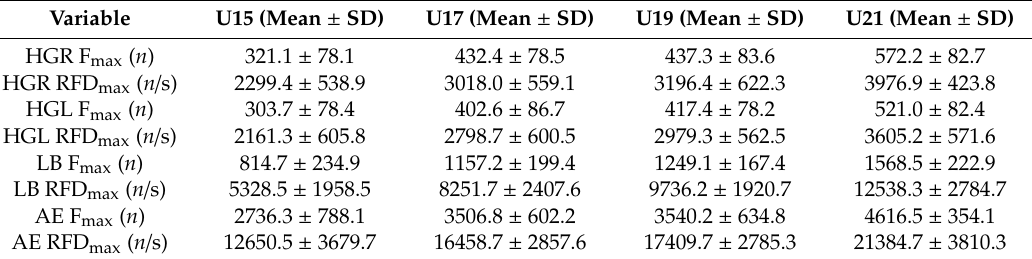
Table 2. Descriptive statistics of male subjects’ isometric strength.